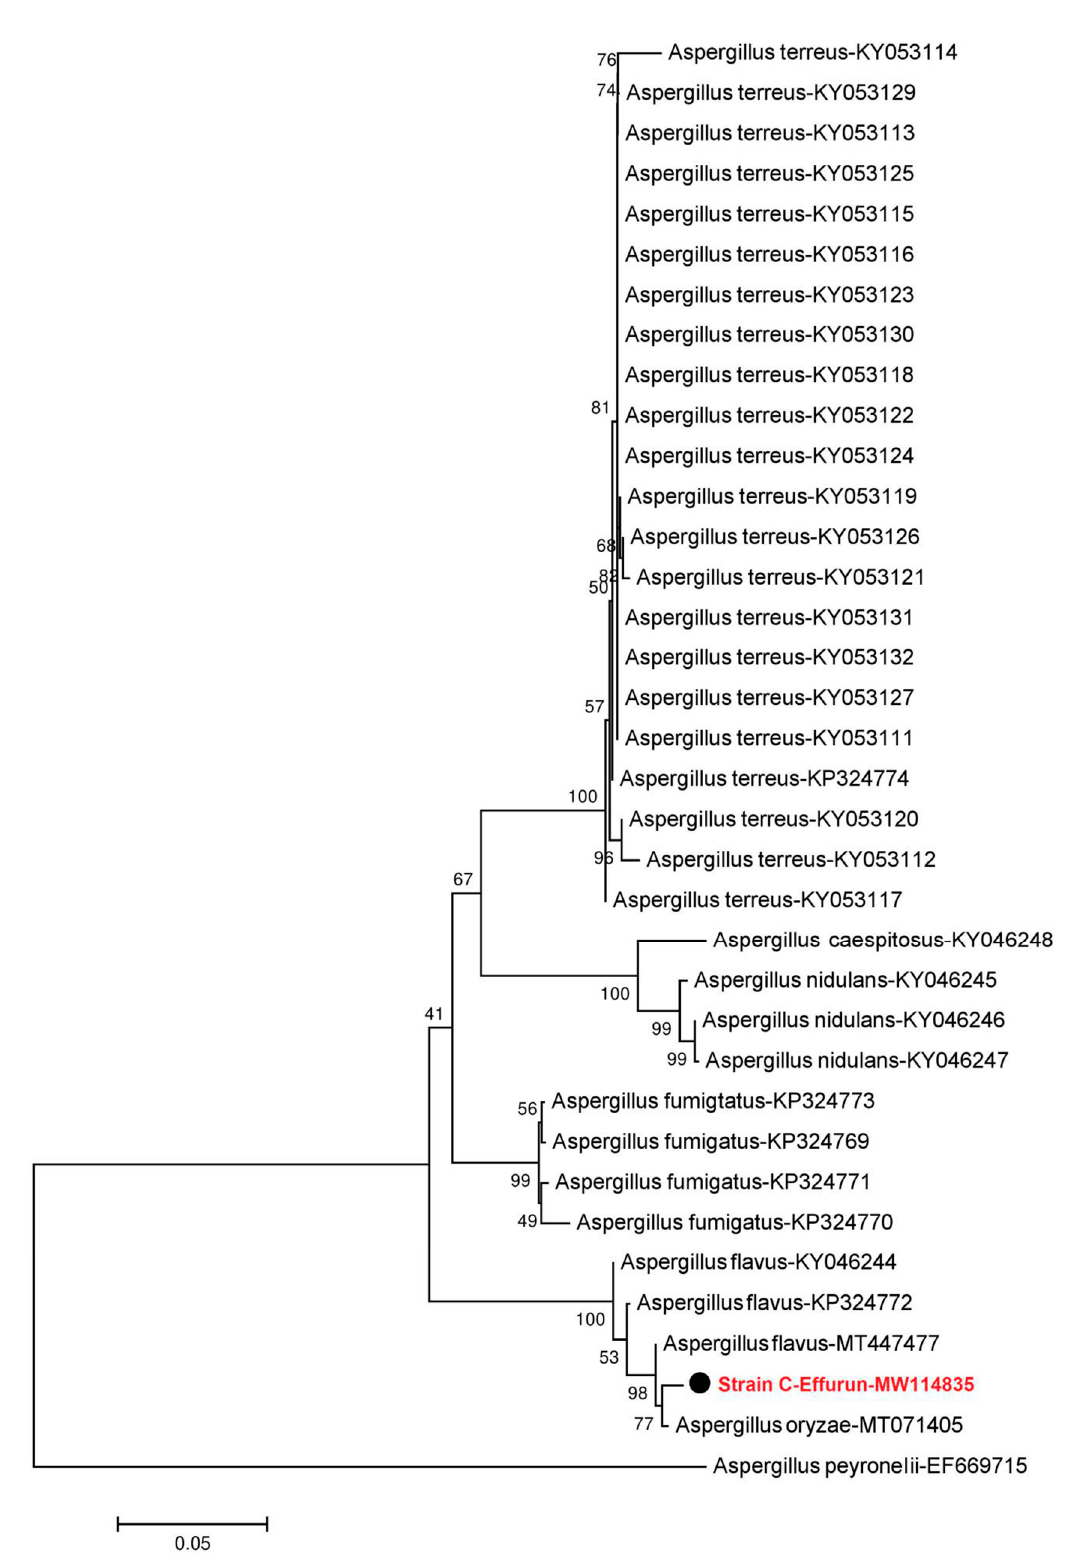
Figure 2. Neighbour-joining phylogenetic tree showing the relationship between the Aspergillus sequence from strain C-Effurun isolated from oil-contaminated soil in this study and selected database relatives. Kimura 2-parameter distances were used. Bootstrap values were based on percentages of 1000 replicates. Aspergillus peyronelii (EF669715.1) was used as the outgroup.